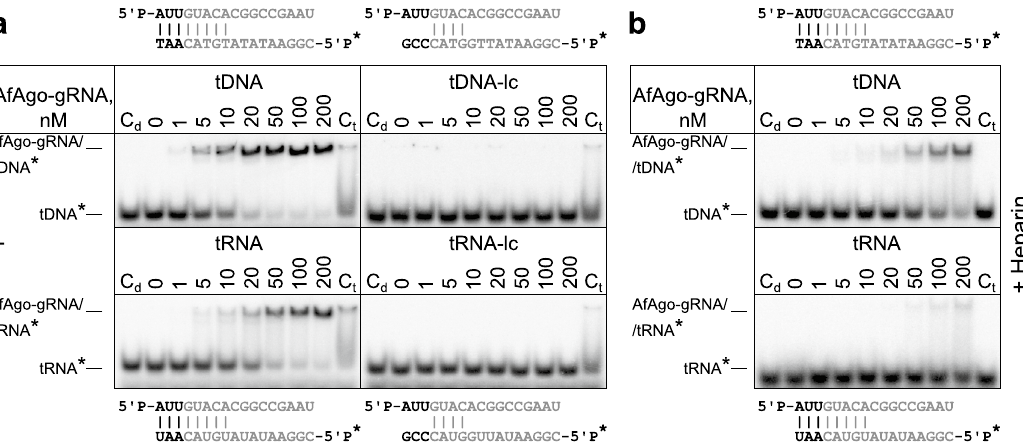
Figure 3. AfAgo RNA-guided NA targeting mechanism and double-stranded nucleic acid binding probed using EMSA. ( a ) Titration of labelled target ssDNA (top) and ssRNA (bottom) with a pre-formed AfAgo-guide RNA complex (1:2 ratio, AfAgo concentrations indicated above each lane) for either 8 nt complementary (left) or 4 nt complementary (lc-“low complementarity”, right) targets. A schematic of guide-target complementarity is shown adjacent to each respective gel, with 5 ′ -terminal bases of the guide and 3 ′ -terminal bases relevant to AfAgo base recognition highlighted in black, remaining strands in grey. 5 ′ 32 P-labelled target strands are denoted with an asterisk. C d -duplex control, where guide and target were mixed in the absence of AfAgo at a ratio equivalent to lane “200”.